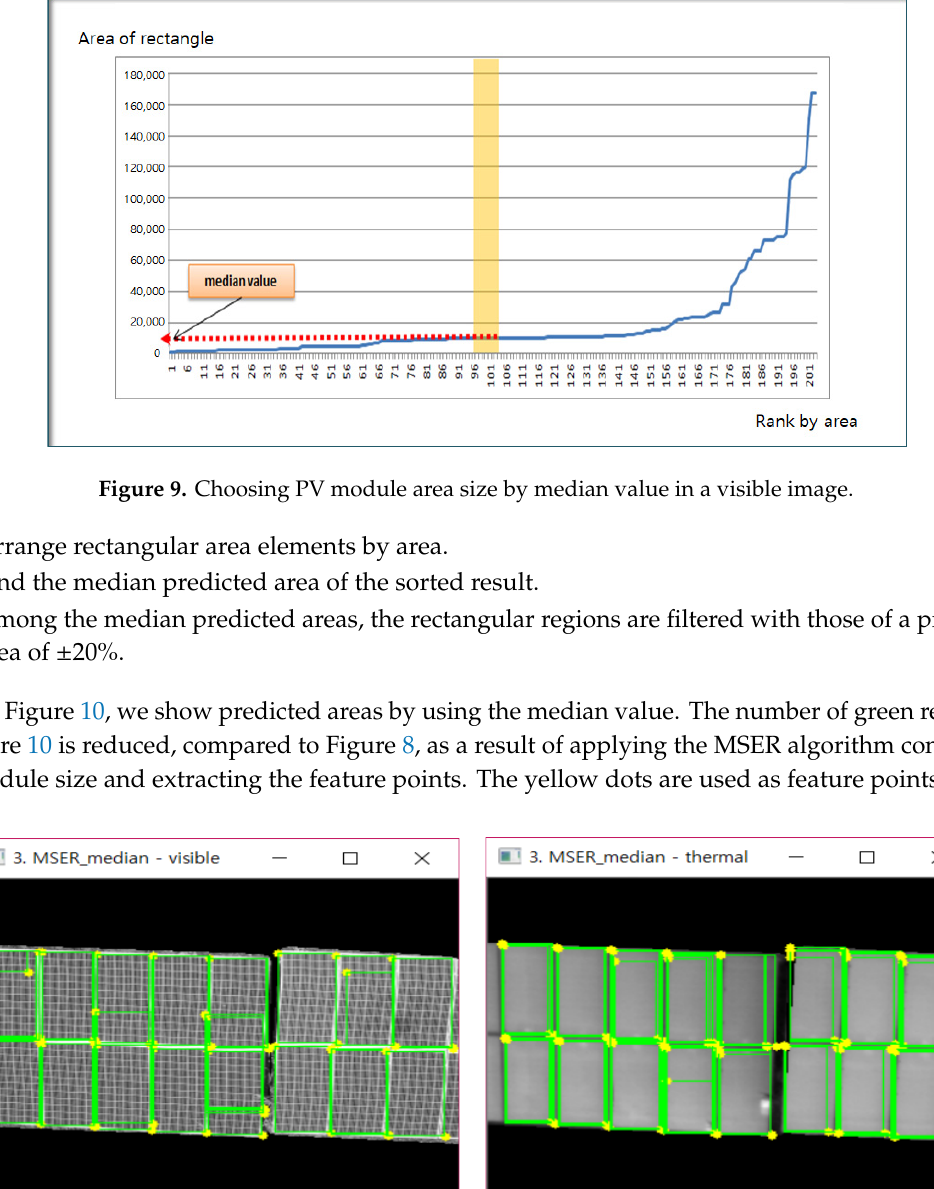
Figure 8. MSER algorithm without consideration of module size: ( a ) result of visible image gray MSER algorithm; ( b ) result of thermal image MSER algorithm.